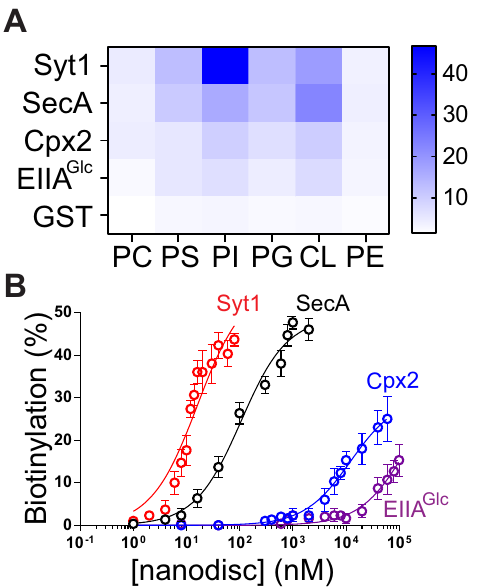
Fig. 3 Using nanodisc-ID to pro fi le and quantify pMP binding to lipids. A Heat map of PL ef fi ciencies of the indicated proteins by TurboID-18A nanodiscs containing the indicated lipids. B Equilibrium titration of TurboID- 18A nanodiscs with peripheral proteins. The interactions of syt1 with PI ( K d = 16 nM), SecA with CL ( K = 106 nM), cpx2 with PI ( K = 12 µ M), and d d EIIA Glc with CL ( K d = 140 µ M) were characterized by PL using TurboID-18A nanodiscs. PL ef fi ciencies of the indicated proteins were then plotted against TurboID-18A nanodisc concentrations. Apparent binding af fi nities were determined by fi tting to a one-site binding equation using GraphPad. Data are shown as mean ± s.d., n = 3 independent experiments.